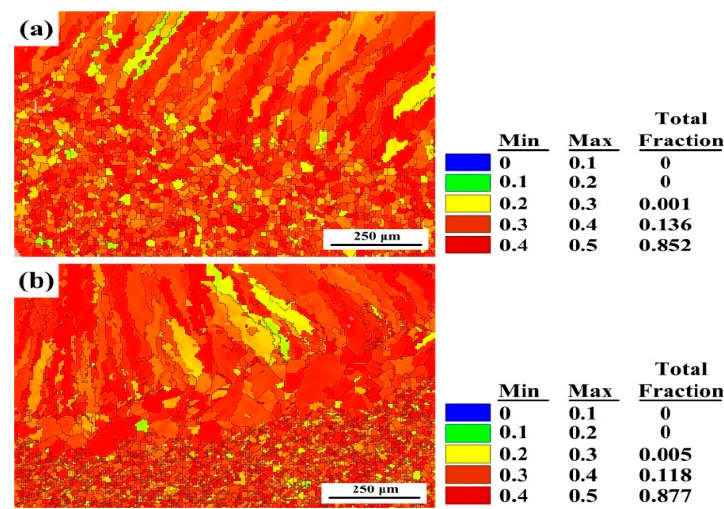
Figure 10. Schmid factor of the different thicknesses of plates along the fusion line: ( a ) 1670-8 and ( b ) 1670-14.